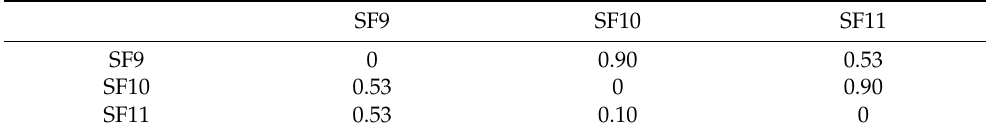
Table A2. Direct-relation matrix in standard fuzzy subsets—Decision-maker 1 ( Adaptability